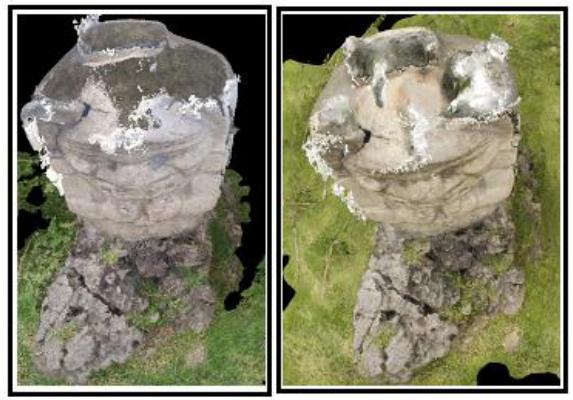
Figure 17. Error Top Object, 3D Model Lenovo Smartphone (Left) Model 3D Canon Camera